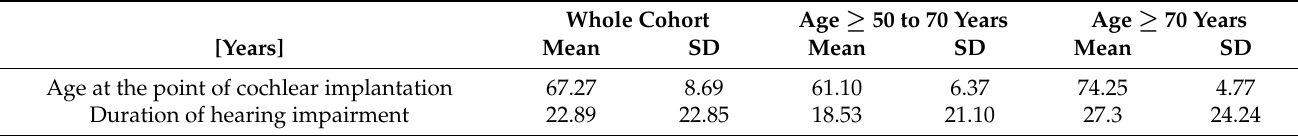
Table 1. General patients’